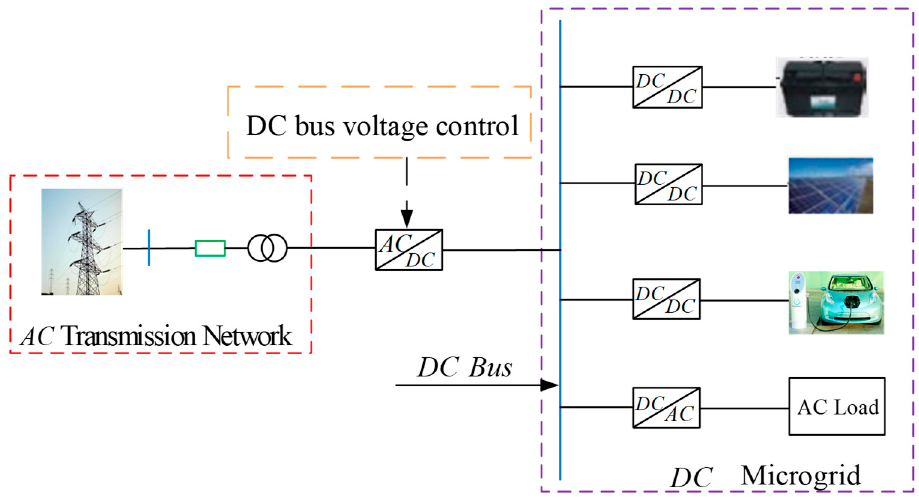
Figure 1. System structure of DC distribution network.